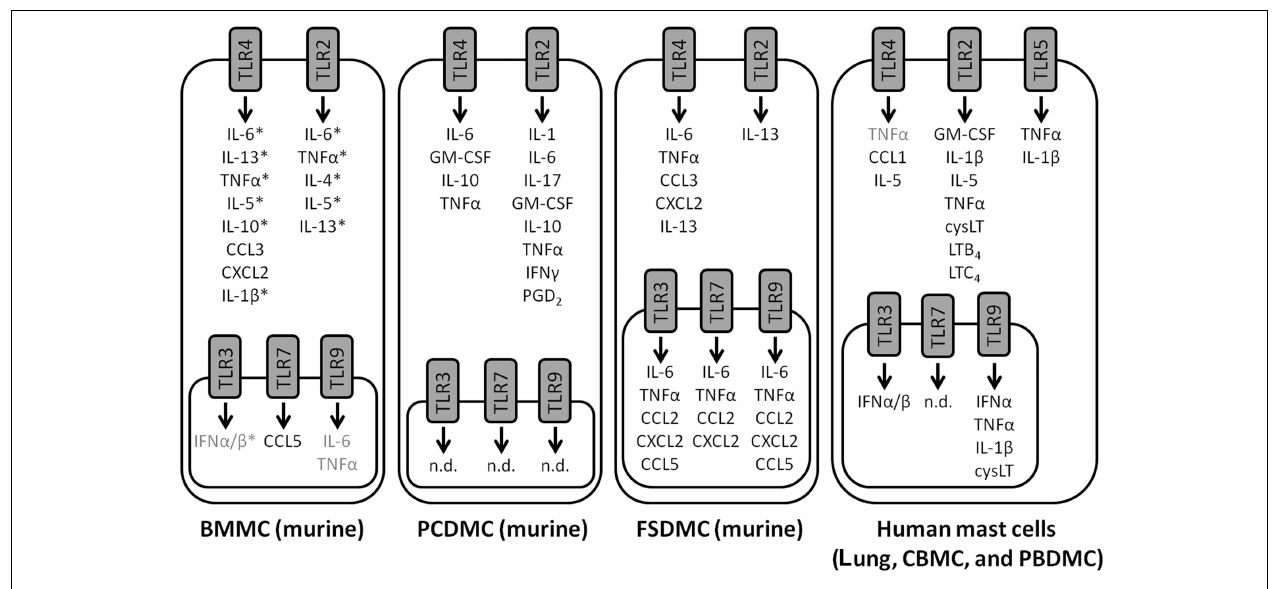
human mast cells.Where there is discrepancy in the literature, molecules are shown in grey. *indicates instances where it has been demonstrated with the use ofTLR-deficient cells or blocking antibodies that the ligand is acting via the indicated receptor.